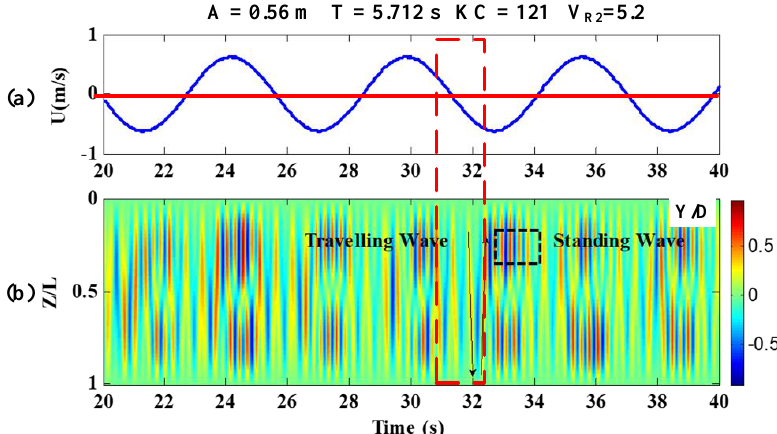
Figure 8. Spatial and temporal distribution of the VIV response in the case of KC = 56 for V R2 = 5.2.